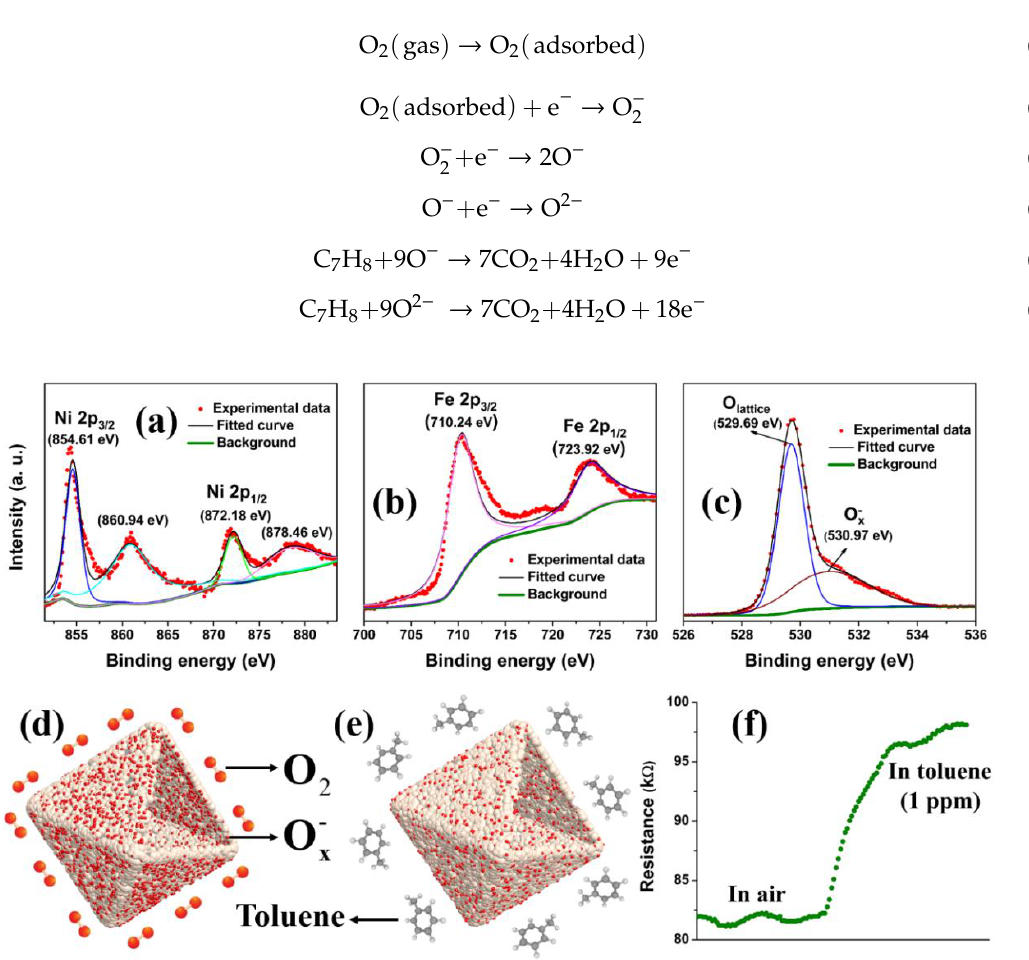
Figure 9. High-resolution XPS spectra for Ni 2p ( a ), Fe 2p ( b ), and O 1s ( c ), and a schematic illustration of the sensing mechanism of the NiFe 2 O 4 nano-octahedrons in air ( d ), and in toluene ( e ) with the obverse real resistance change in air and 1 ppm toluene ( f ).